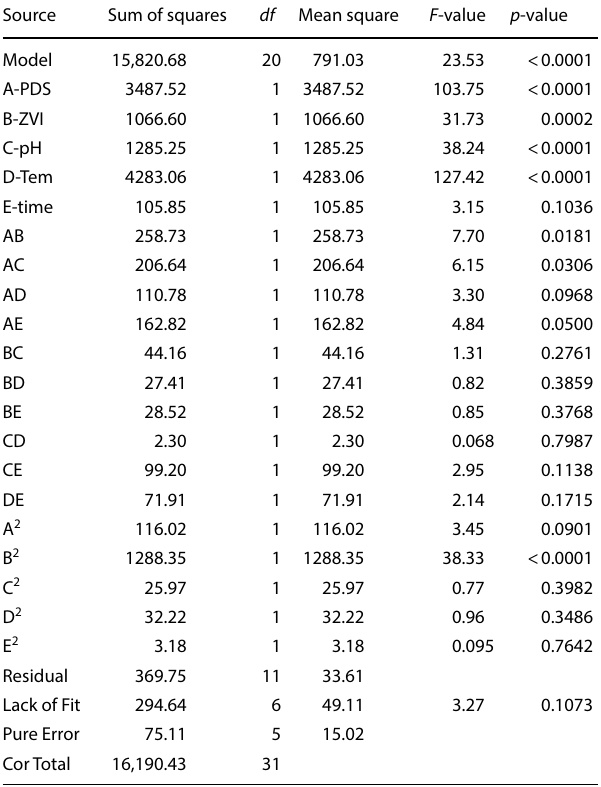
Table 4 Analysis of variance (ANOVA) results of quadratic model for AMR removal Source